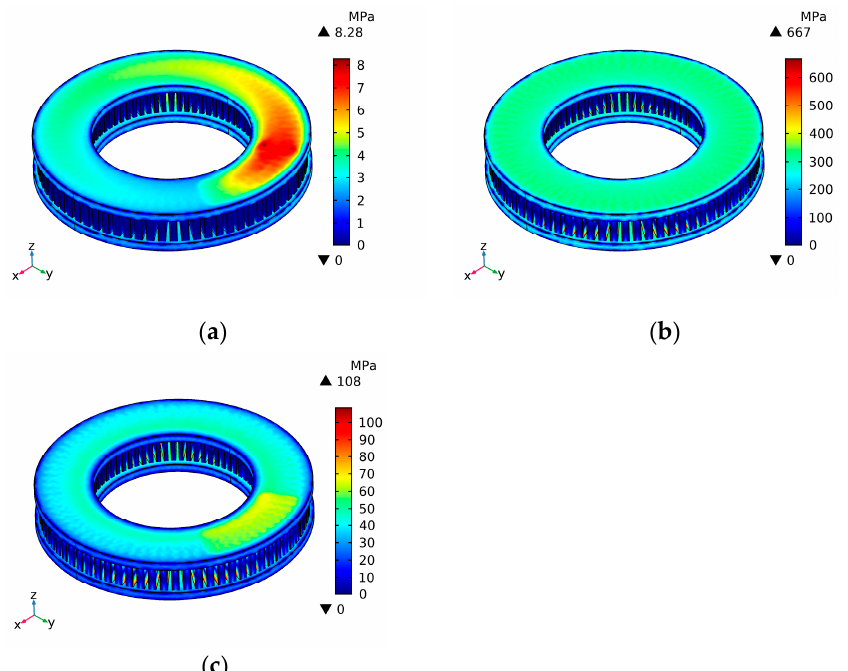
Figure 14. Stress cloud on the surface of a ventilated brake disc at different braking moments. ( a ) Braking 0.05 s; ( b ) braking 35 s; ( c ) braking 70 s.